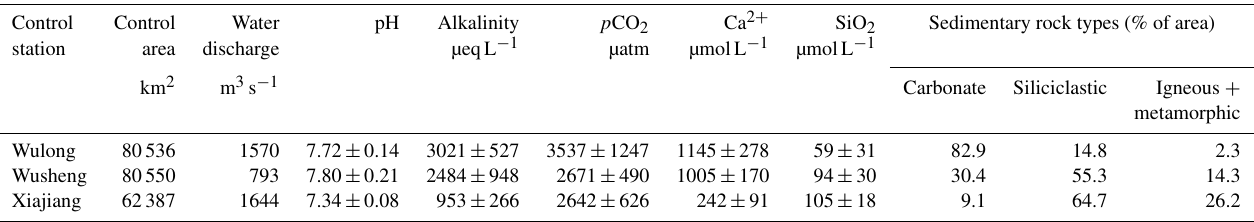
Table 3. Hydro-geochemical features of the Wujiang (Wulong station), Jialingjiang (Wusheng station), and Ganjiang (Xiajiang station) catchments. Control Control Water pH Alkalinity SiO 2 Sedimentary rock types (% of area) station